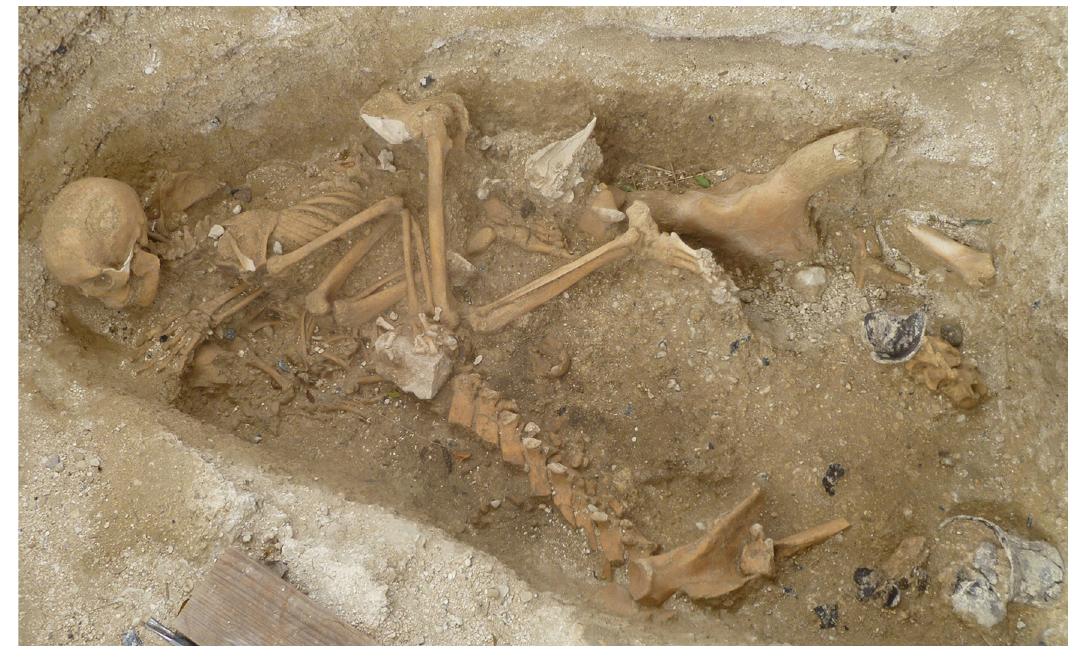
Figure 7: Menneville “ Derrière le Village. ” Burial of a woman with domestic animals, half an aurochs bucrane, a piece of deer antler, a pottery and a burnt wooden object, segment 571. After Thevenet, 2014, Figure 23, and Thevenet et al., forthcoming, Figure 12. Photo UMR 8215